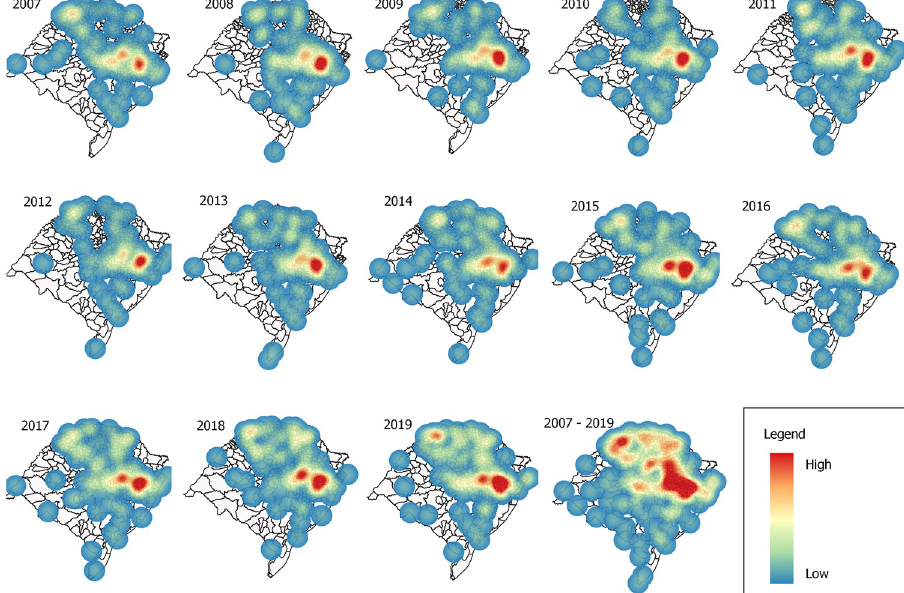
Fig 3. Hotspot analysis of leptospirosis incidence from 2007 to 2019 in Rio Grande do Sul, Brazil.